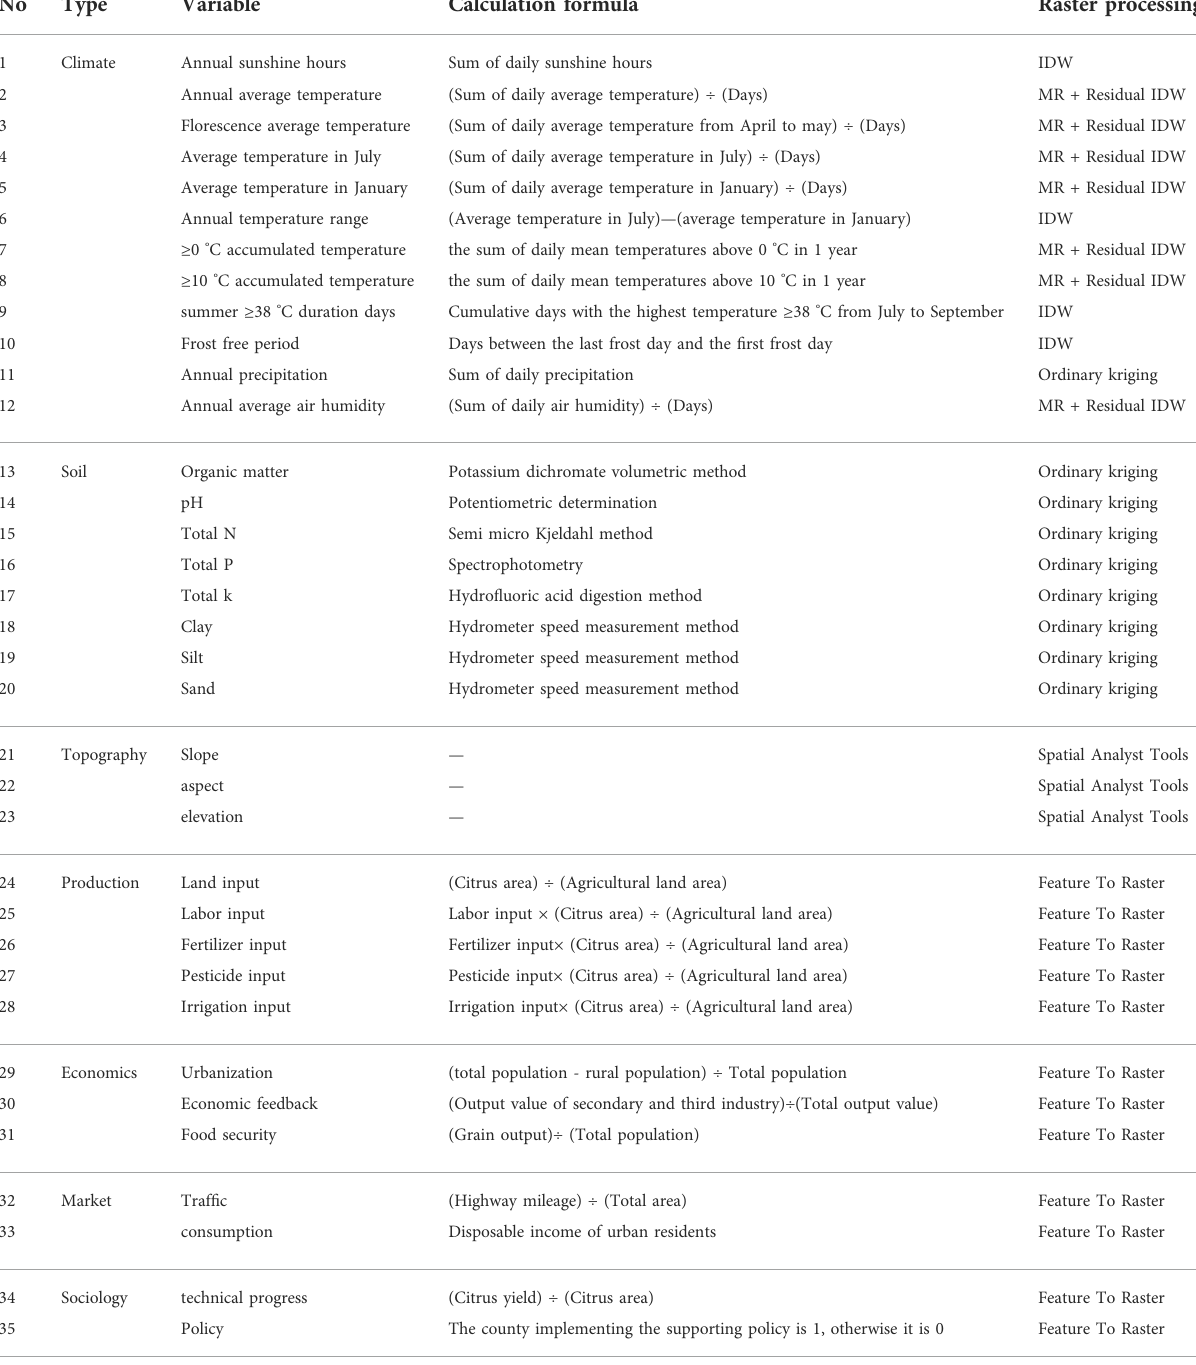
TABLE 2 Calculation formula and raster processing of environment